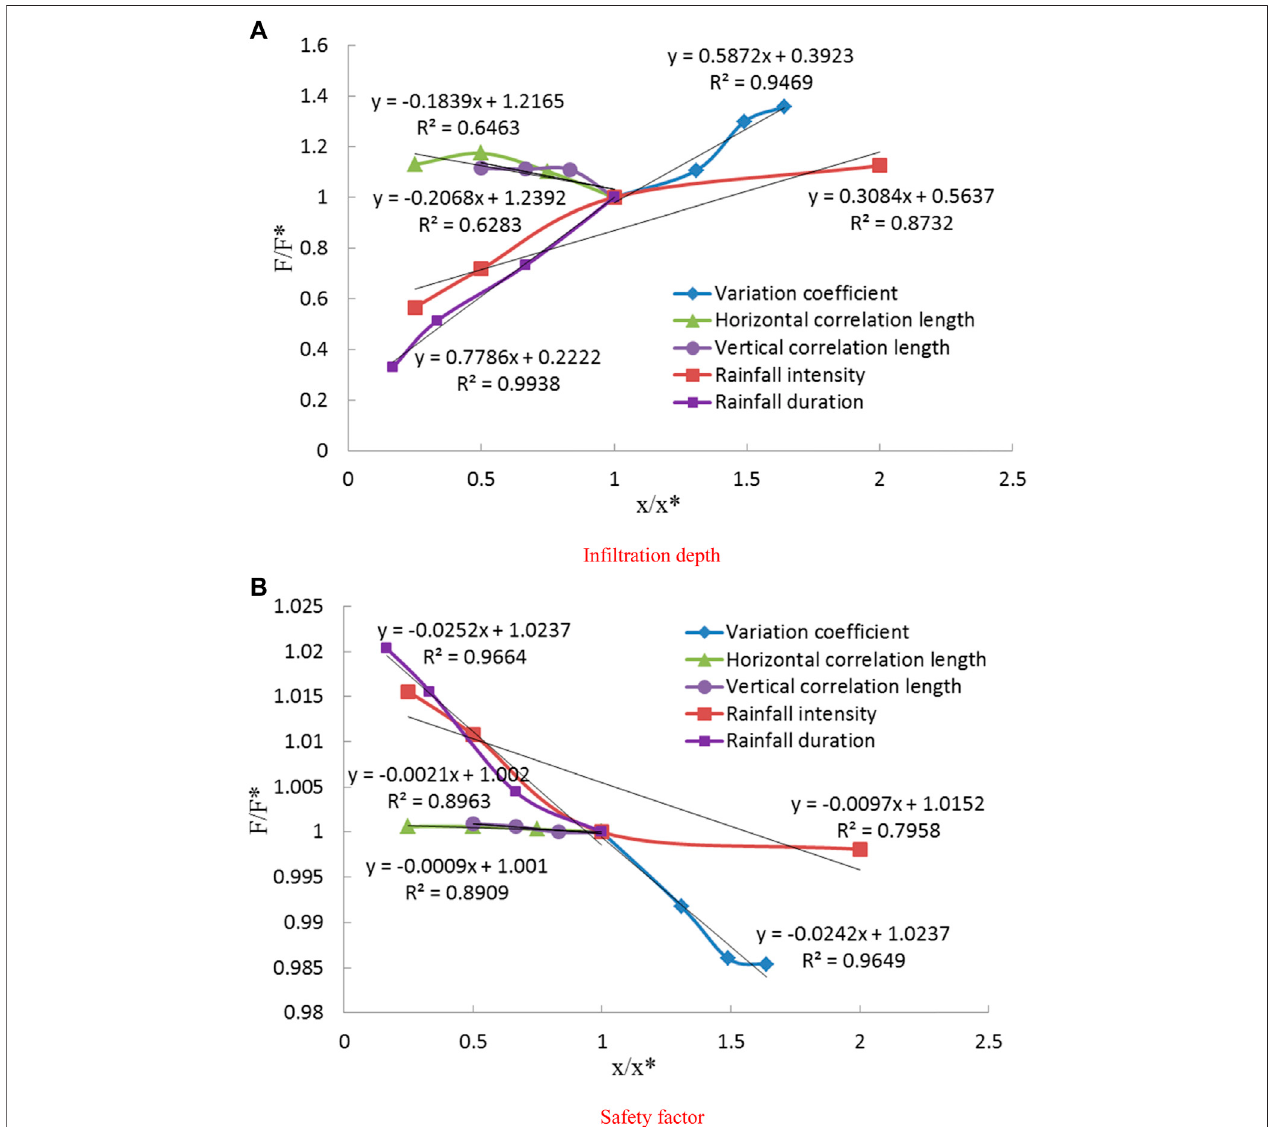
FIGURE 11 | Sensitivity comparison of different impact factors: (A) In fi ltration depth, (B) Safety factor.